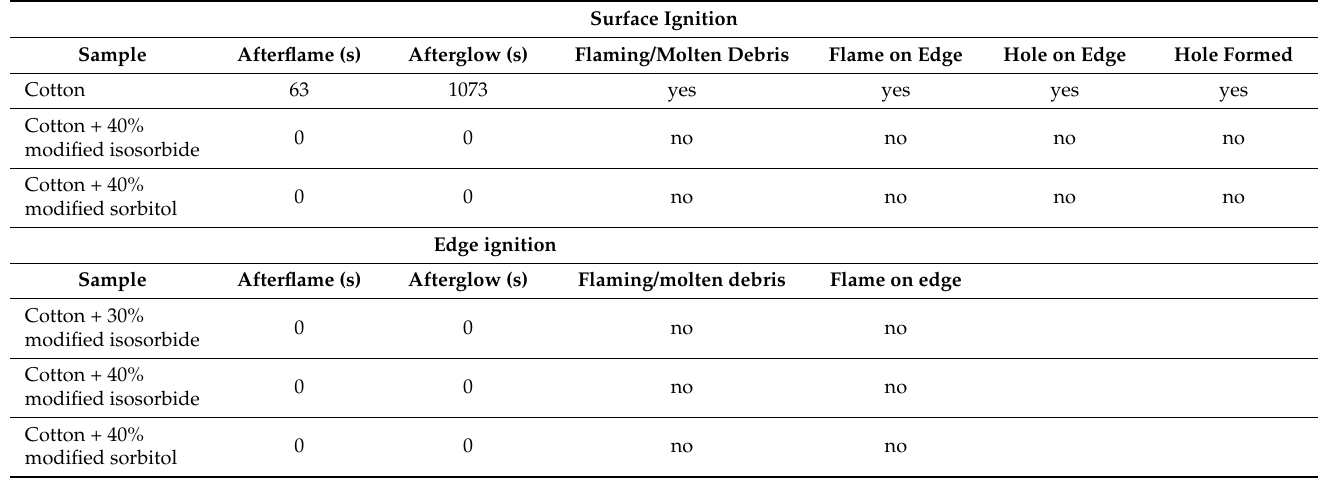
Table 1. Overview of ISO 15025